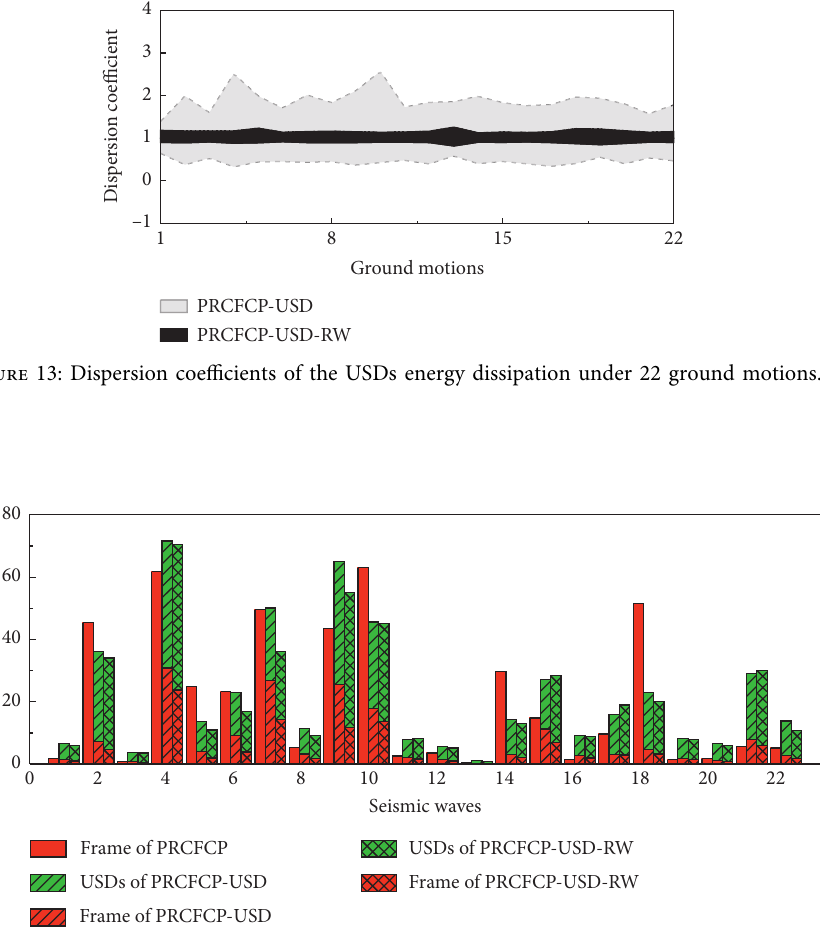
Figure 14: Comparison of the total energy dissipation under 22 ground motions.